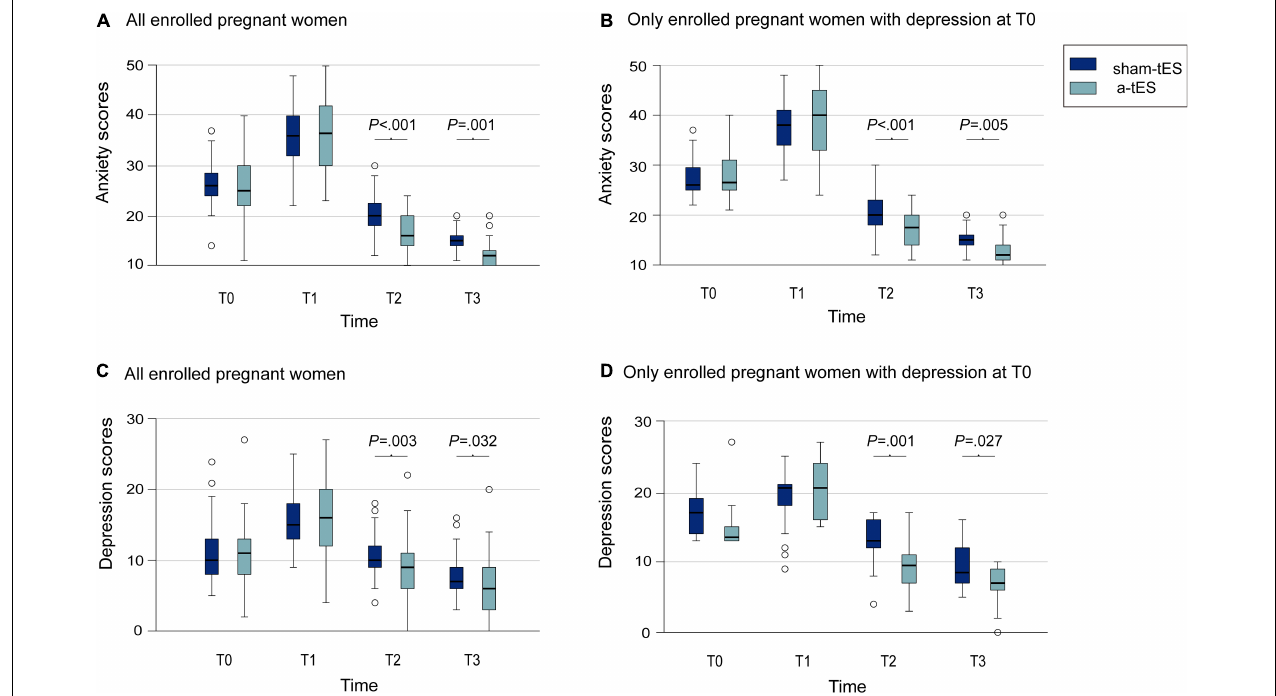
FIGURE 3 | Comparison of anxiety and depression scores of pregnant women between the a-tES group and sham-tES group. (A) Changes in anxiety scores in all enrolled pregnant women. (B) Changes in anxiety scores in only enrolled pregnant women with anxiety at T0. (C) Changes in depression scores for all enrolled pregnant women. (D) Changes in depression scores for only enrolled pregnant women with depression at